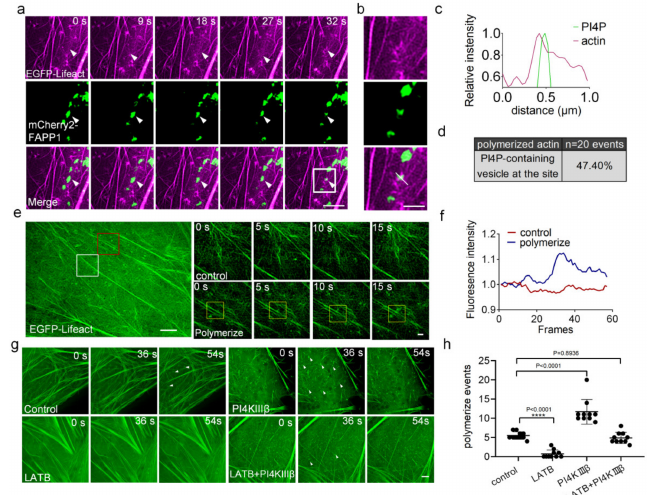
Figure 3. PI4Ps promote actin polymerization in cells. ( a ) Representative SIM images of PI4P- containing vesicles (tagged with mCherry2-FAPP1, green) and actin (tagged with EGFP-Lifeact, magenta) in live U-2 OS cells. Scale bar: 2 µ m. ( b,c ) White arrows from ( a ) show actin filament polymerization where PI4P vesicles are present. Line-scan analysis of relative fluorescence intensities from the white line in the merged image is shown. Scale bar: 2 µ m. ( d ) Quantitative statistics of the relative localization of the PI4P-containing vesicles and actin polymerization. ( e ) SIM images showing actin filaments (tagged with EGFP-Lifeact). The white box indicates a site without actin polymerization; on the top right panel, there is a long-term image showing actin dynamics. The red box indicates a site with actin polymerization; below the right panel, there is a long-term image showing actin polymerization. Scale bars: 5 µ m and 1 µ m. ( f ) Analysis of the relative fluorescence intensities in the red and white boxes is shown. ( g ) Time course analysis of changes in actin filaments in normal cells and cells in the presence of LatB or PI4KIII β or both LatB and PI4KIII β . White arrows indicate the site of actin polymerization. Scale bar: 2 µ m. ( h ) Quantification of the number of actin polymerization events as presented in picture ( g ) on the basis of 10 cells. Cells from three independent experiments. All graphs show the mean ± SEM. Statistical significance: n.s., p > 0.05; **** p <